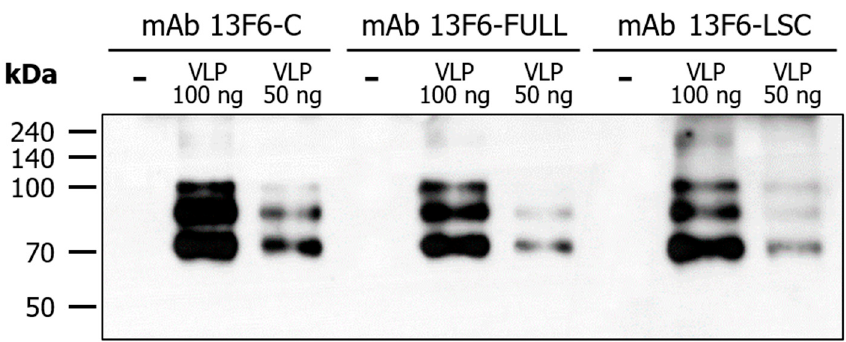
Figure 6. Detection of Ebola EBOV-like particles (VLPs) by mAb 13F6-FULL and mAb 13F6-LSC. Immunoblot analysis was performed to confirm the binding of mAbs 13F6 to VLPs. The VLPs were detected by mAb 13F6-C, mAb 13F6-FULL, or mAb 13F6-LSC and horseradish peroxidase (HRP)-conjugated goat anti-human IgG HC fragment specific antibody. Numbers on the left indicate molecular weight (kDa). − : negative control, 1× PBS; VLP: Ebola VLP; mAb 13F6-C, commercial 13F6 antibody as a positive control.